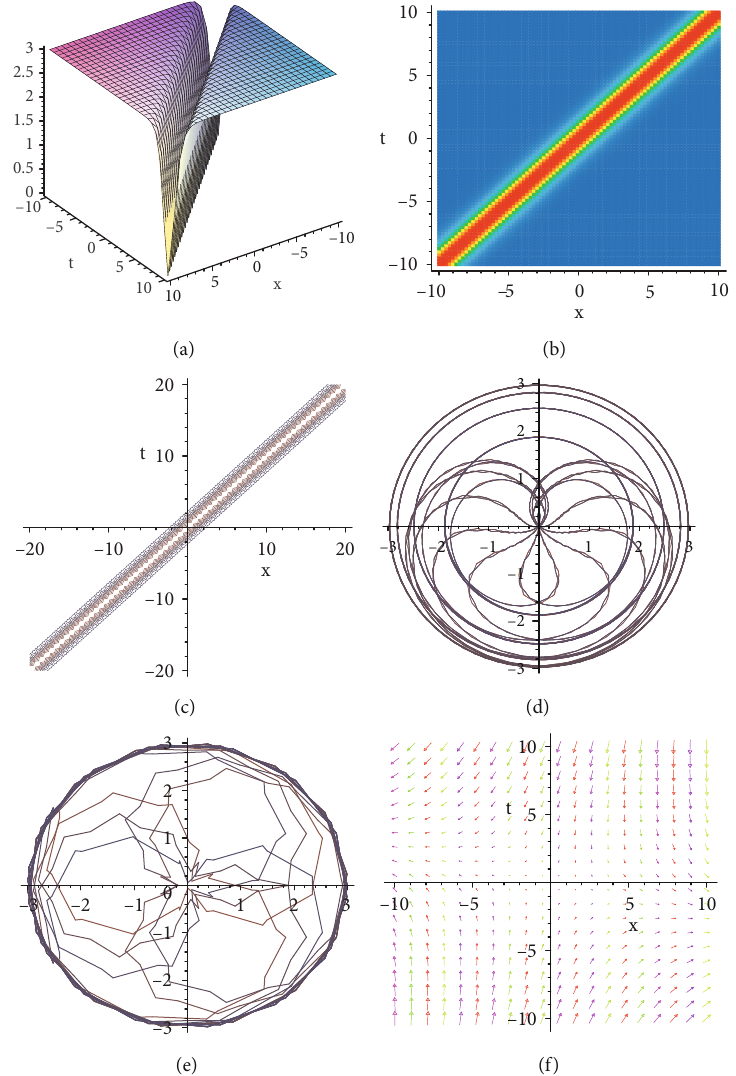
= k = 1 , k = − 1 , θ = 0 , 1 3 2